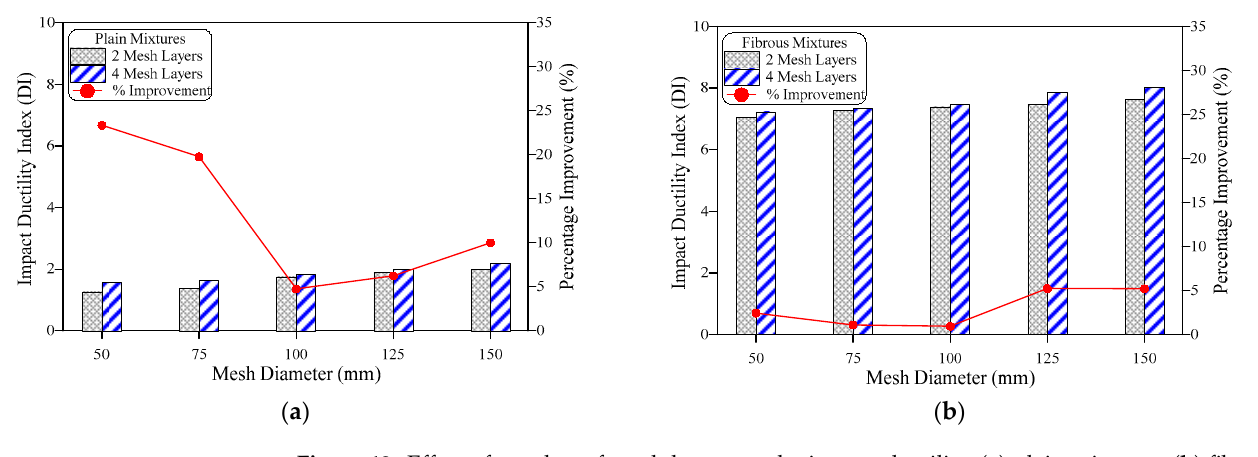
Figure 12. Effect of number of mesh layers on the impact ductility, ( a ) plain mixtures, ( b ) fibrous mixtures.